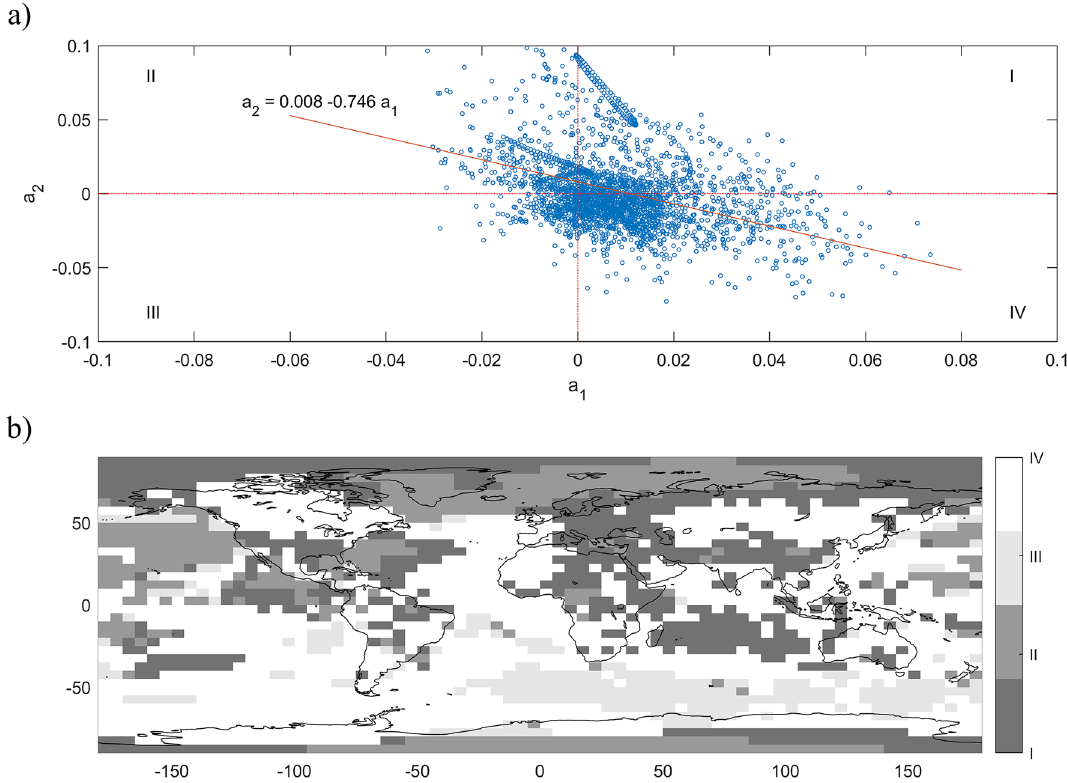
Figure 1. Spatial patterns of annual warming trends. ( a ) Shows a scatter plot of the estimates of a i1 and a i2 in Eq. (1), for the changes in slope parameters for the first (1954) and second break (1993), respectively. Depending on the signs of a i1 and a i2 , there are four cases: I (+, +), II (−, +), III (−, −), and IV (+, −), each of which corresponds to a quadrant in the scatter plot. ( b ) Presents the geographical distribution of the four cases in a gray map, with case I being the darkest gray and case IV being white. This figure was created using MATLAB R2018a (https ://www.mathw